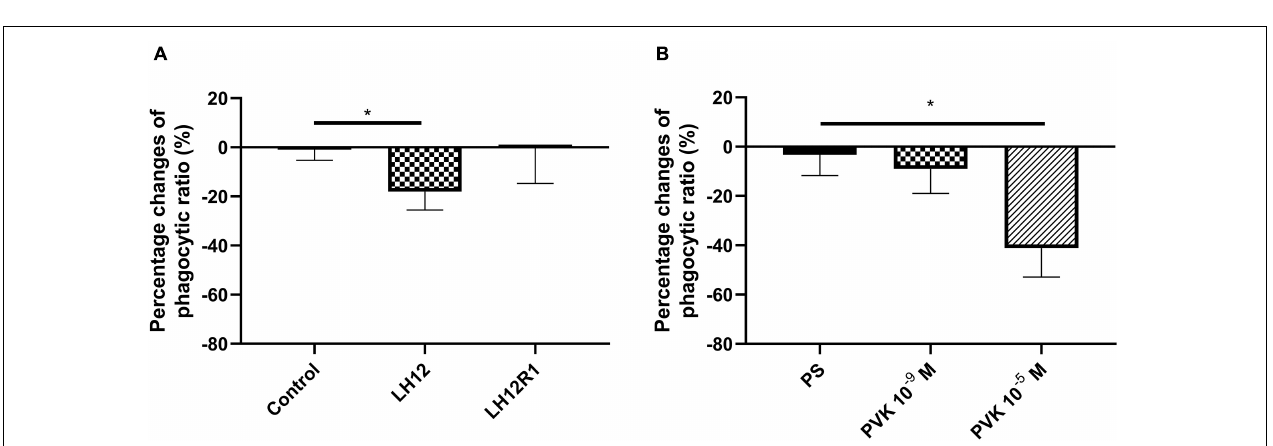
FIGURE 4 | Percent change in the proportion of N. vespilloides haemocytes involved in phagocytosis after 12 h of low-humidity treatment (LH12), low humidity and recovery time (LH12R1) (A) , and 1 h after administration of Tenmo–PVK-2 at concentrations of 10 − 9 and 10 − 5 M (B) . Control: untreated beetles; PS: beetles analyzed 1 h after injection of physiological saline for beetles. Value are means ± SEM, * p ≤ 0.05.